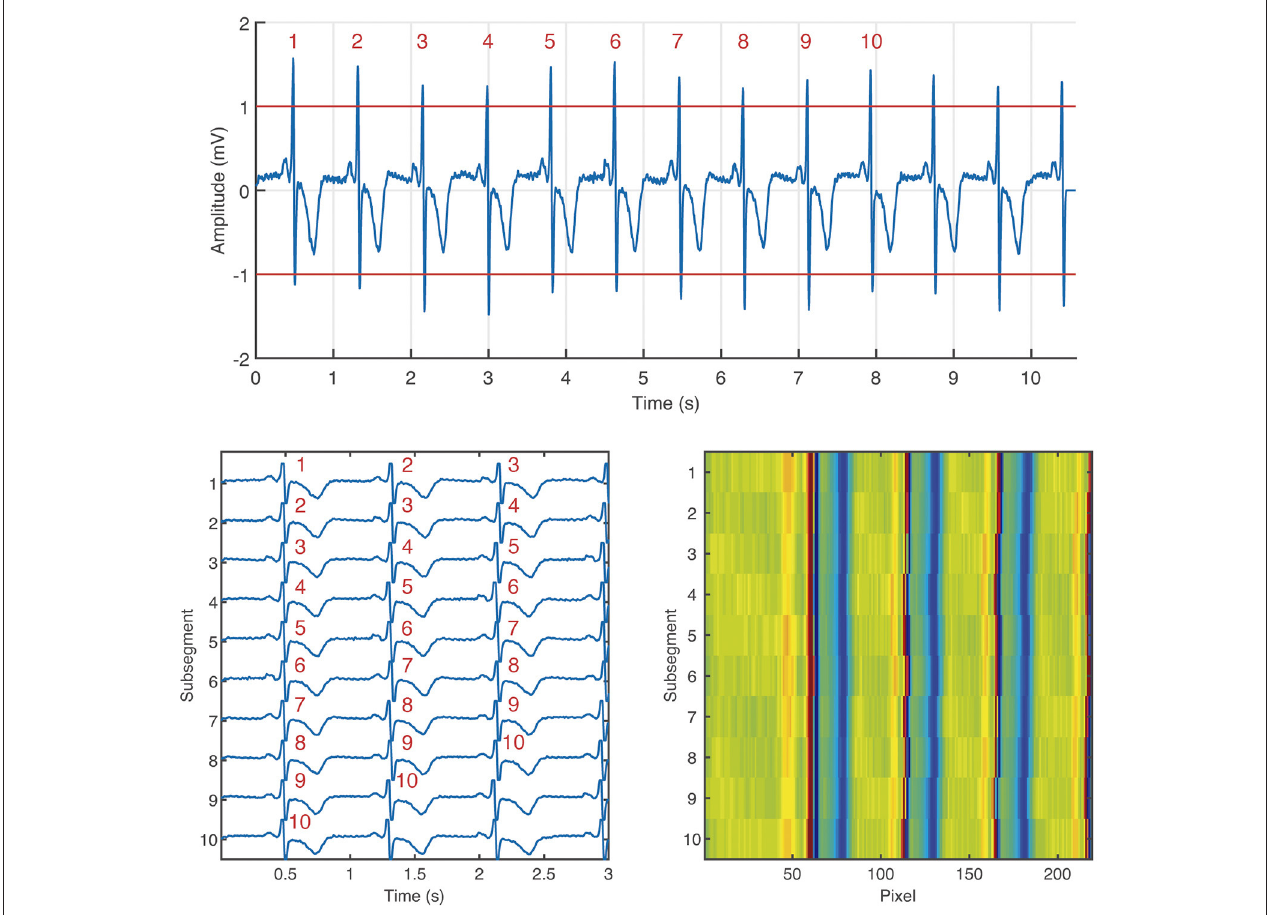
FIGURE 1 | Generation of the ECM-image from an ECG segment labeled as non-AF. Segment taken from channel 1 of the record 04015 in the AFDB. The segment corresponds to the time interval [4,567, 4,578] s. On the top : ECG segment containing 10 beats (labeled with red numbers) plus 2.5 s after the last beat, and 0.5 s before the first beat. Bottom left : ECM containing the 10 subsegments aligned vertically, the corresponding beats from the ECM segment are labeled in red numbers. Bottom right :